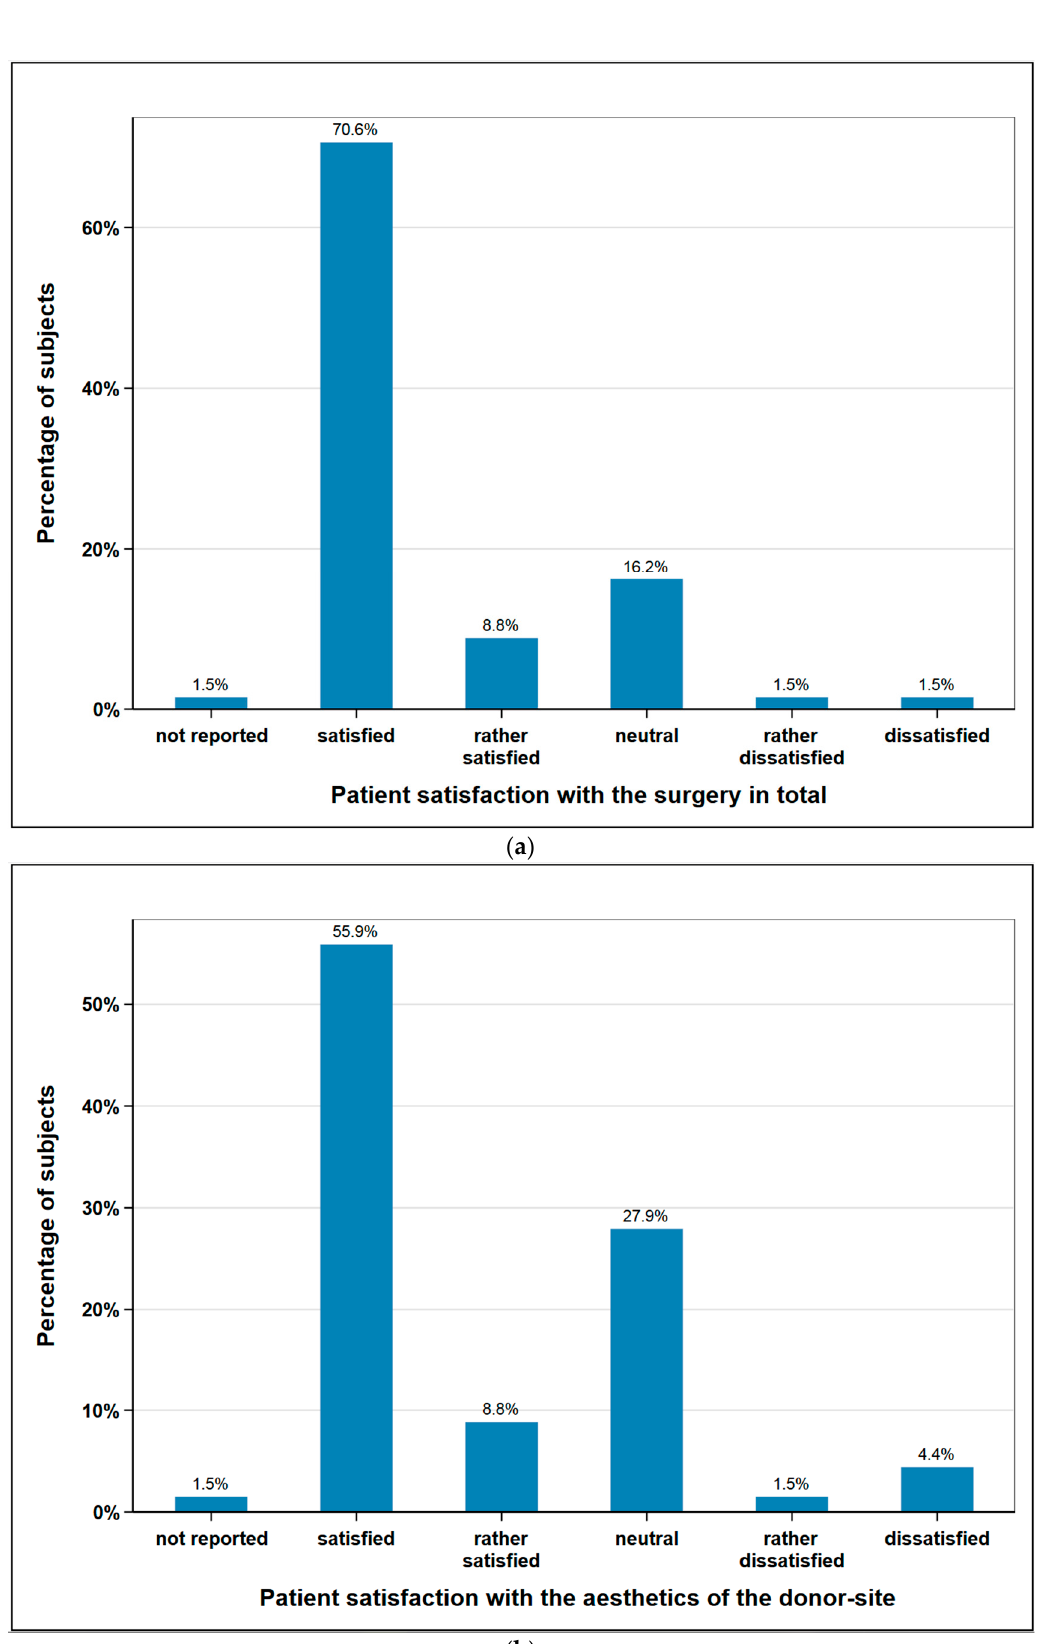
Figure 5. Subjects satisfaction with ( a ) the surgery in total ( n = 68); ( b ) aesthetics of the donor-site ( n = 68).